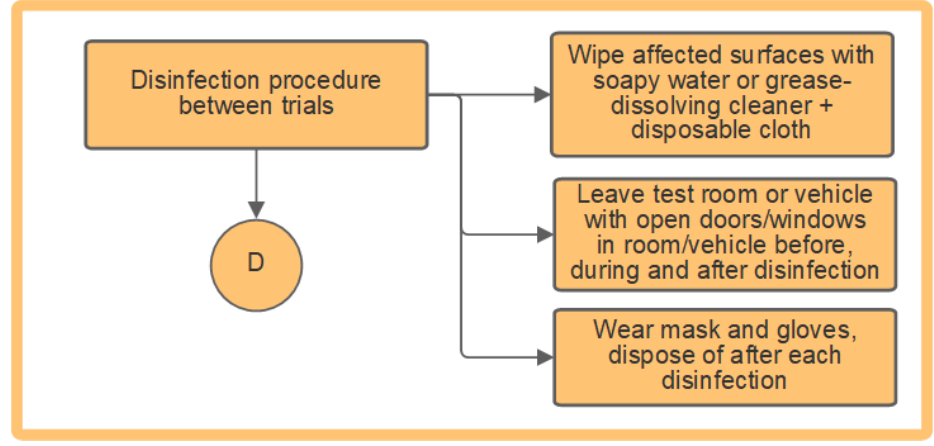
Figure 10. Disinfection of the experimental environment.